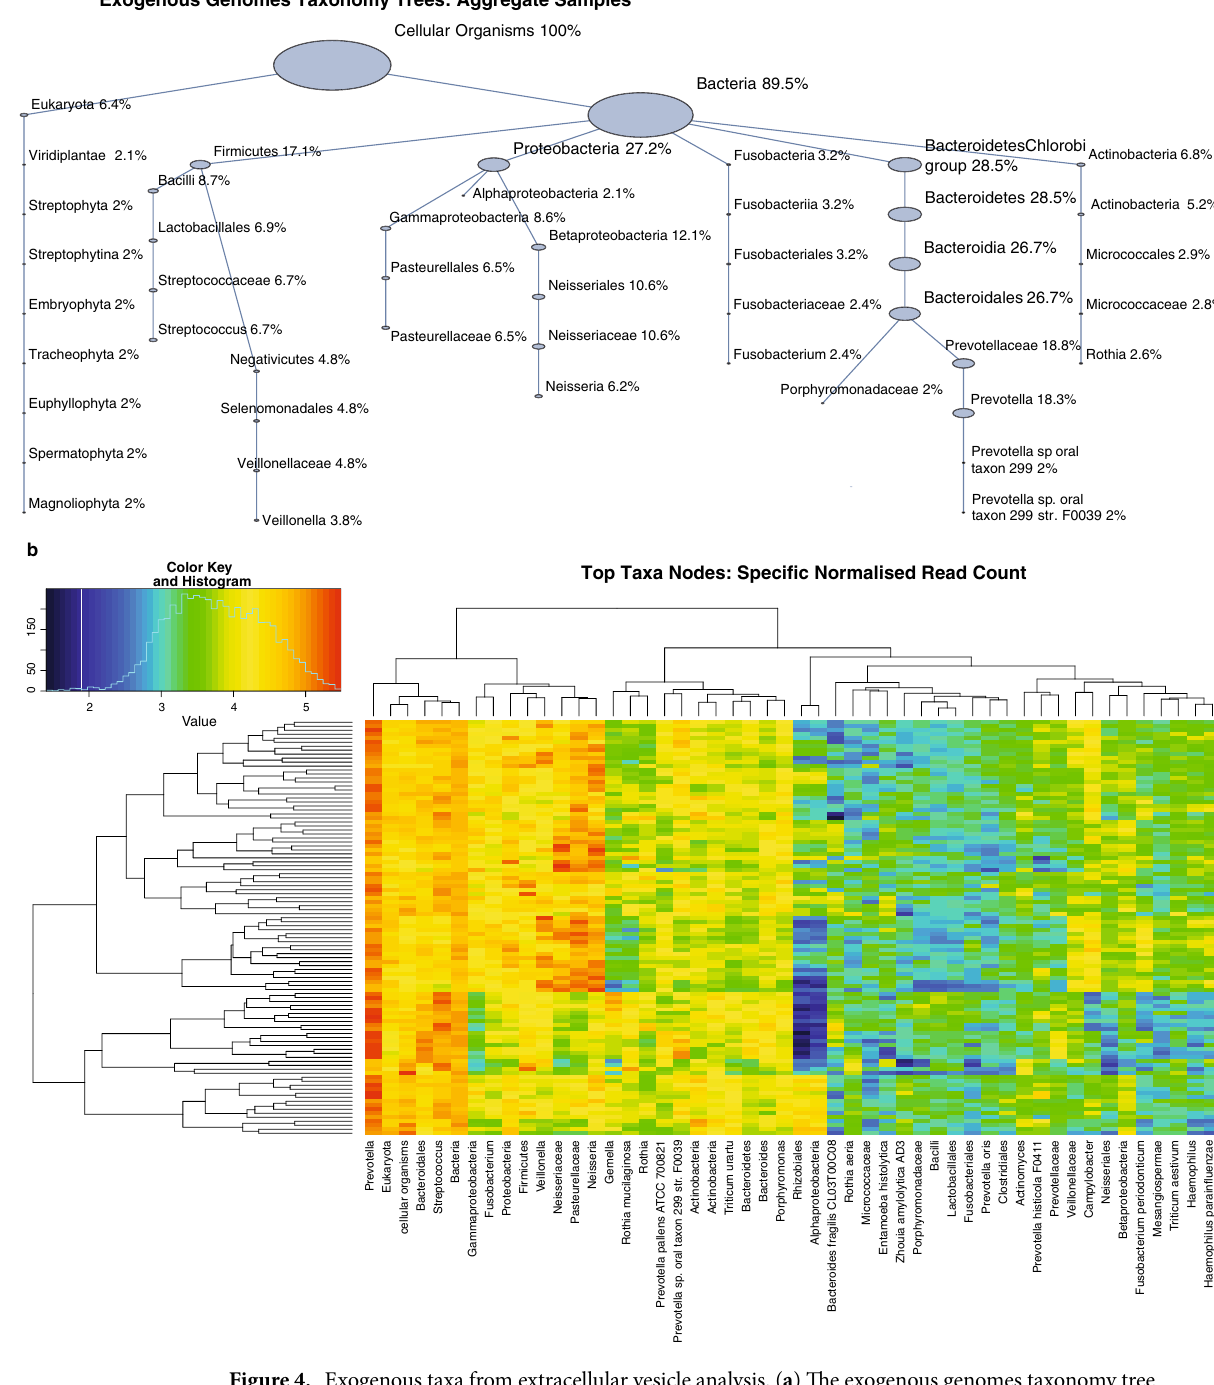
Figure 4. Exogenous taxa from extracellular vesicle analysis. ( a ) The exogenous genomes taxonomy tree based on mapped EV reads from the aggregate samples is shown. The tree has been truncated to include only nodes with relative reads compared to the Cellular Organisms root of ≥ 2% . ( b ) The top taxa nodes indicate consistency across samples (vertical transformation 43–45 to generate periodograms whose inverse Fourier transform can then produce a set of auto- correlations at different lags for a given time series. Our classification successively identifies time series from the dataset that have statistically significant autocorrelations at particular time lags. In summary (see “Methods”), MathIOmica ’s classification generates three sets of classes, strictly based on temporal behavior: (1) significant autocorrelations at various lags, (2) no autocorrelations, but with positive spikes (abnormally high signals above baselines present at single timepoints), (3) no autocorrelations, but negative spikes present (abnormally low sig- nals below baseline at single timepoints). Within each class a two-tier classification into groups and subgroups